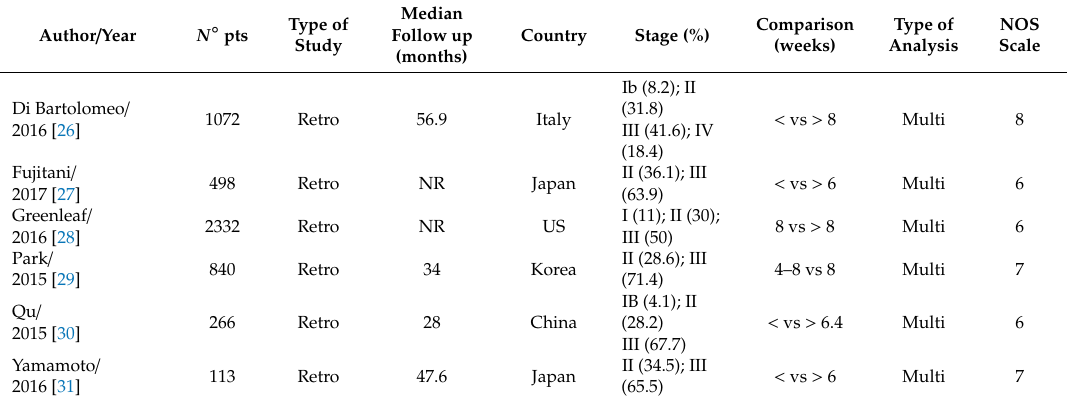
Table 2. Characteristics of included studies for gastric cancer.